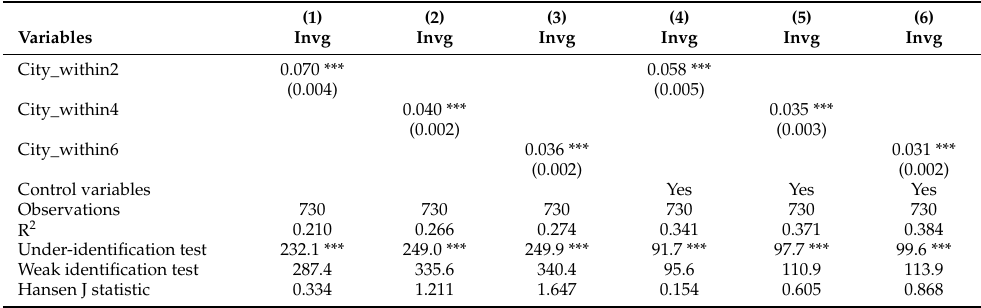
Table 2. Estimated results of the impact of the number of cities accessible within 2, 4, and 6 h by HSR on invention patents granted.